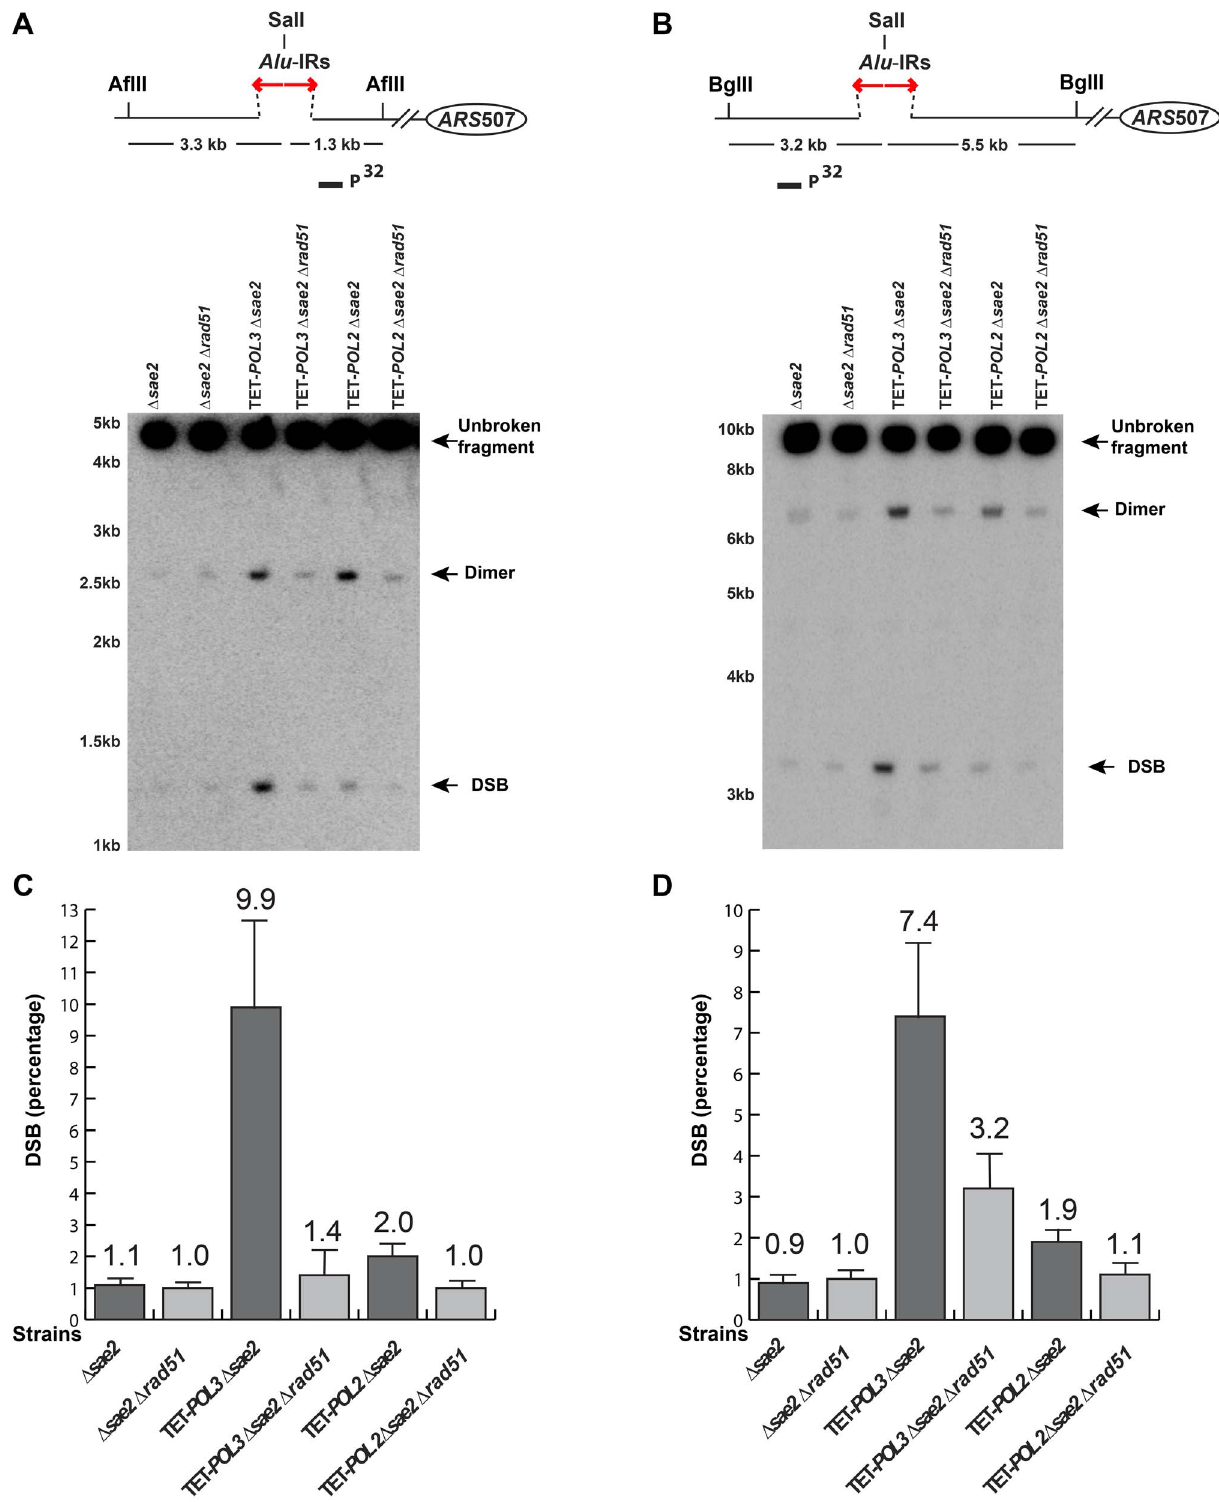
Figure 4. Detection of DSB accumulation in wild-type and mutant strains upon deletion of RAD51 . DSB detection was carried out as described in Figure 2. The strains used in this analysis are: D sae2 , D sae2 D rad51 , TET- POL3 D sae2 , TET- POL3 D sae2 D rad51 , TET- POL2 D sae2 , TET- POL2 D sae2 D rad51 . ( C ) and ( D ) Densitometry analysis of the broken fragments normalized to the intact chromosome V in D sae2 strains in ( A ) and ( B ), respectively. Values are shown as mean (shown on the top of the bars) with standard deviation obtained from at least three independent experiments.